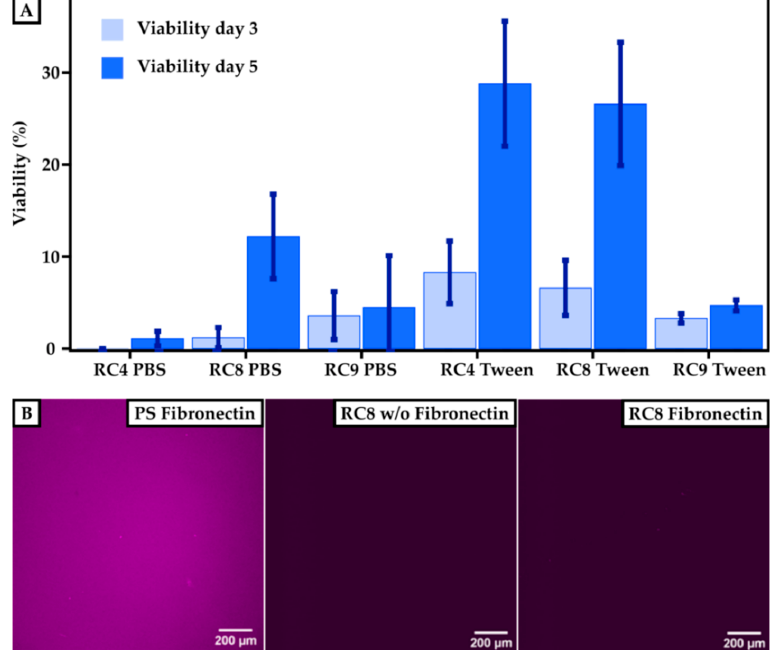
Figure 5. Cell viability on 3D-printed surfaces compared to PS-based control substrates. ( A )